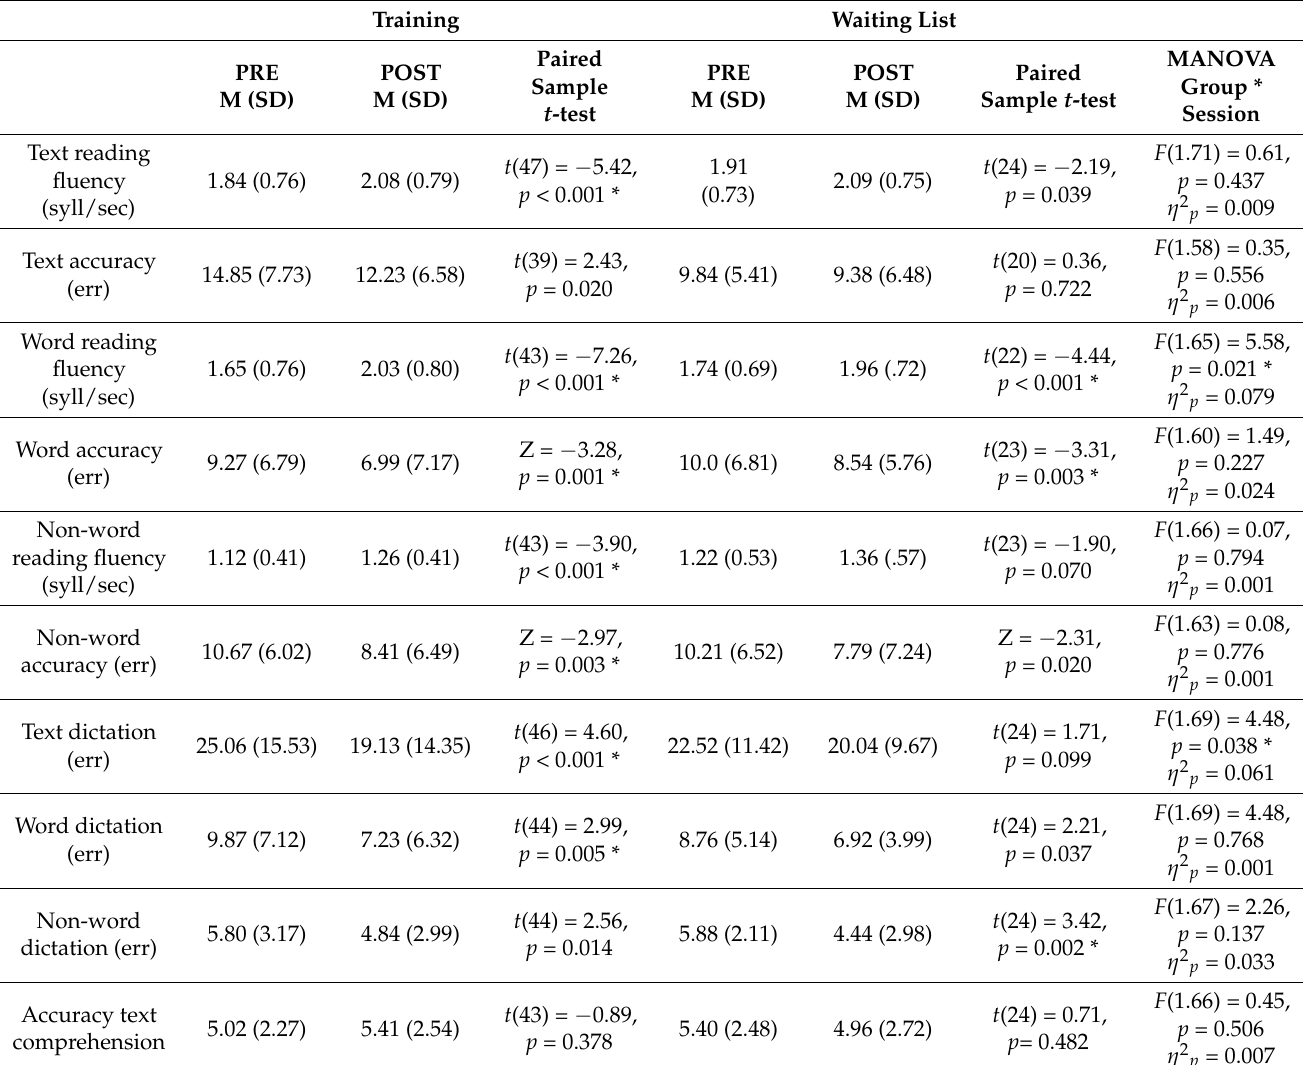
Table 1. Performance at pre- and post-test of children with SLD in the training and waiting list conditions and MANOVA results for the Group * Session interaction. Training Waiting List